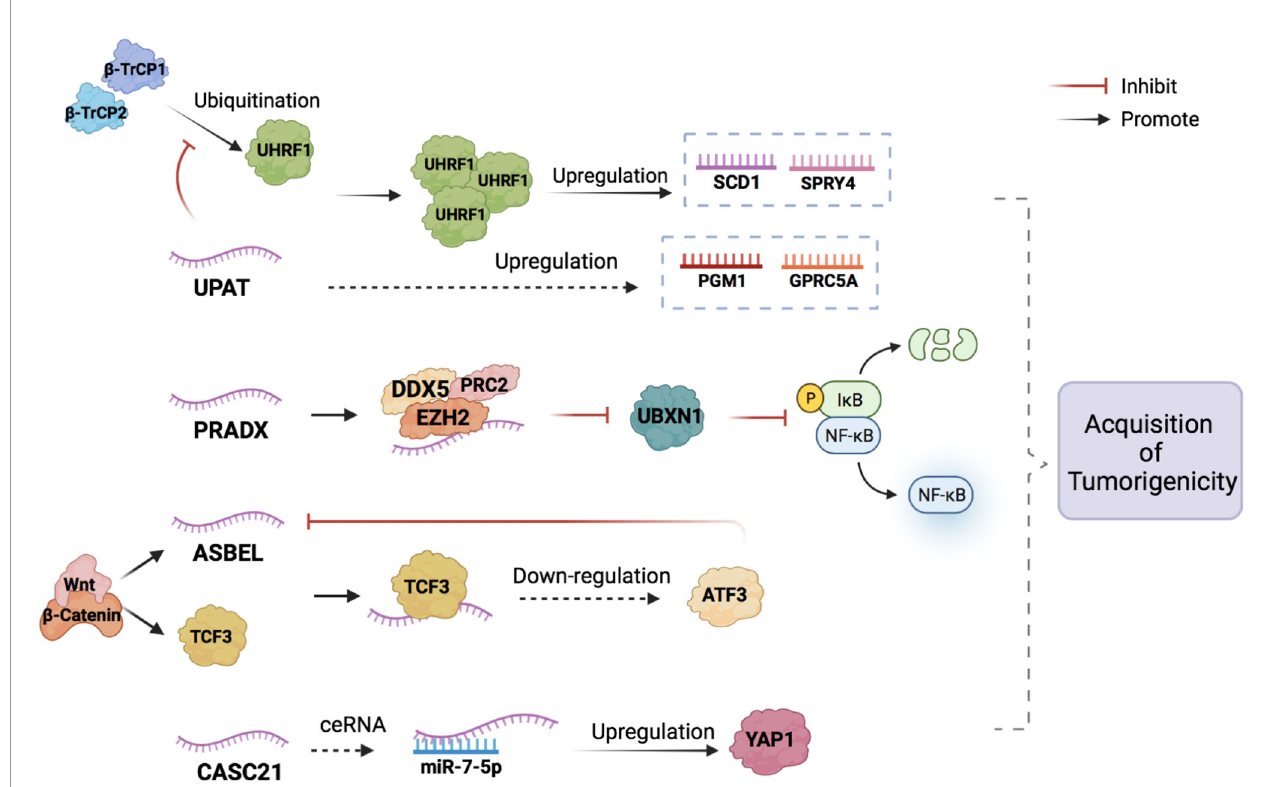
FIGURE 1 | The potential mechanisms of lncRNAs in the CRC occurrence. LncRNAs participate in the acquisition of tumorigenicity of CRC by combining with proteins to form complexes and acting as miRNA sponges